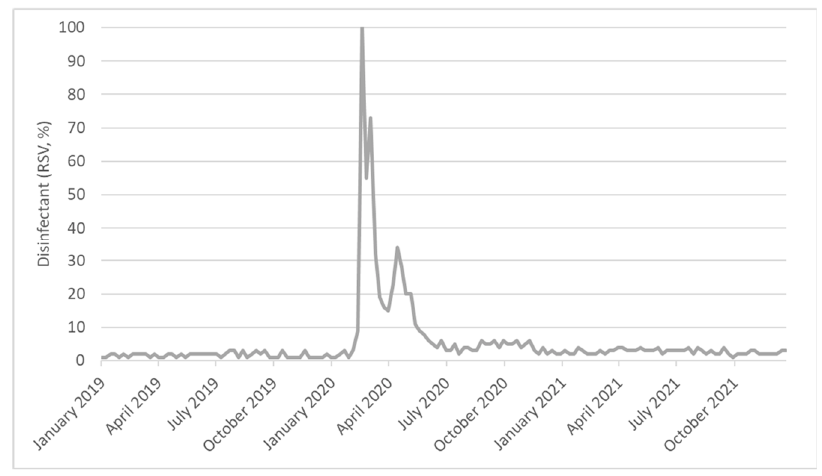
Figure 6. Public interest in the term “disinfectant” based on Google Trends data.